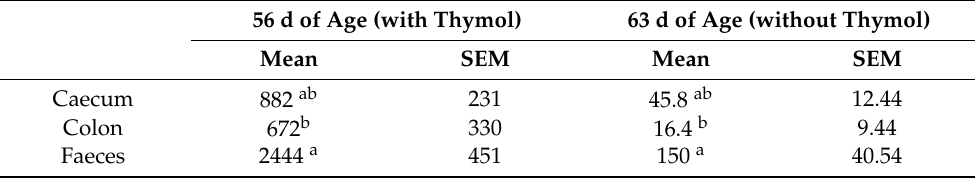
Table 3. Thymol content in caecum, colon, and faeces (ng/g DM). 56 d of Age (with Thymol) 63 d of Age (without Thymol)